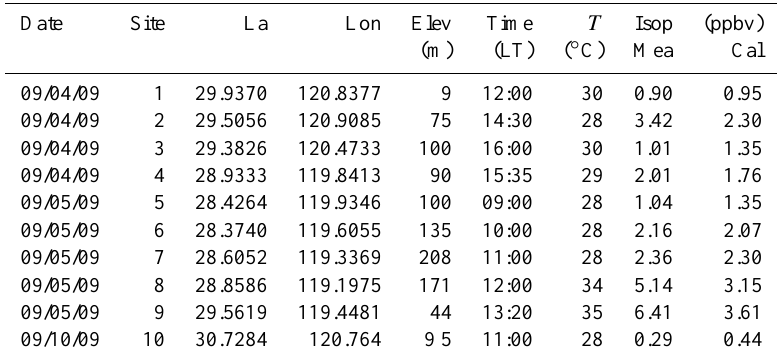
Table 1. Information for the measurement of isoprene concentrations in the forests of the south of Shanghai during September 2009. The sampling duration is